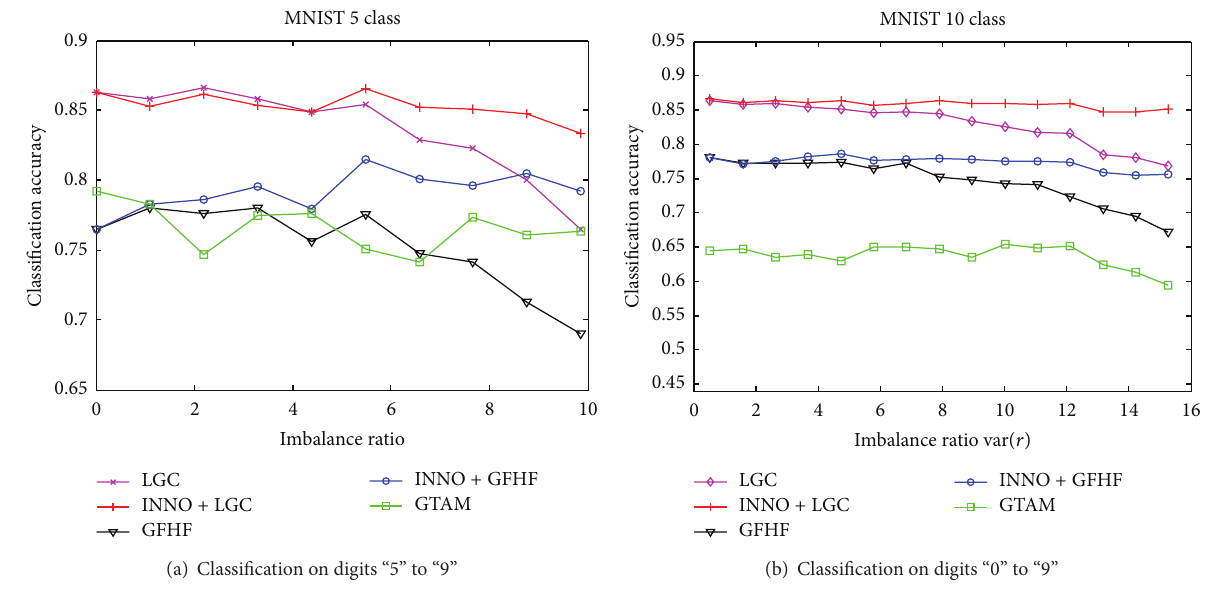
Figure 5: Influence of unbalanced labeled samples to the classification